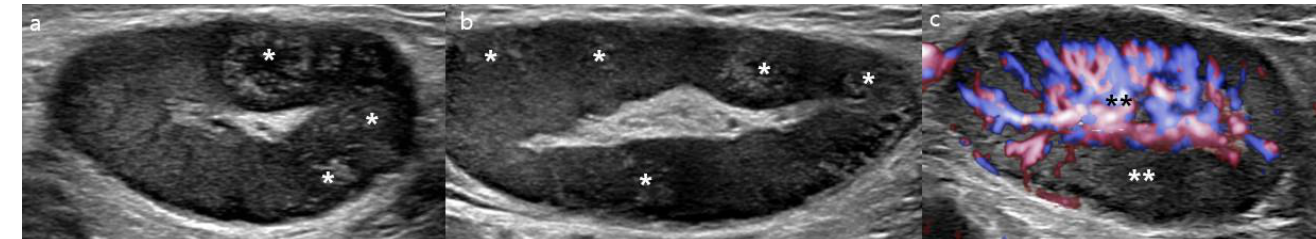
Figure 2. Ultrasonography of the right inguinal lymph node. ( a , b ) There are multiple scattered hyperechoic foci in the enlarged hypoechoic cortex. Note some bright foci form the follicle (white asterisks ), showing a “starry night sign” with ( a ) short axis and ( b ) long-axis views. ( c ) In the color Doppler image, high vascularity is shown mainly in the hilum (black double asterisks) compared with the cortex (white double asterisks).